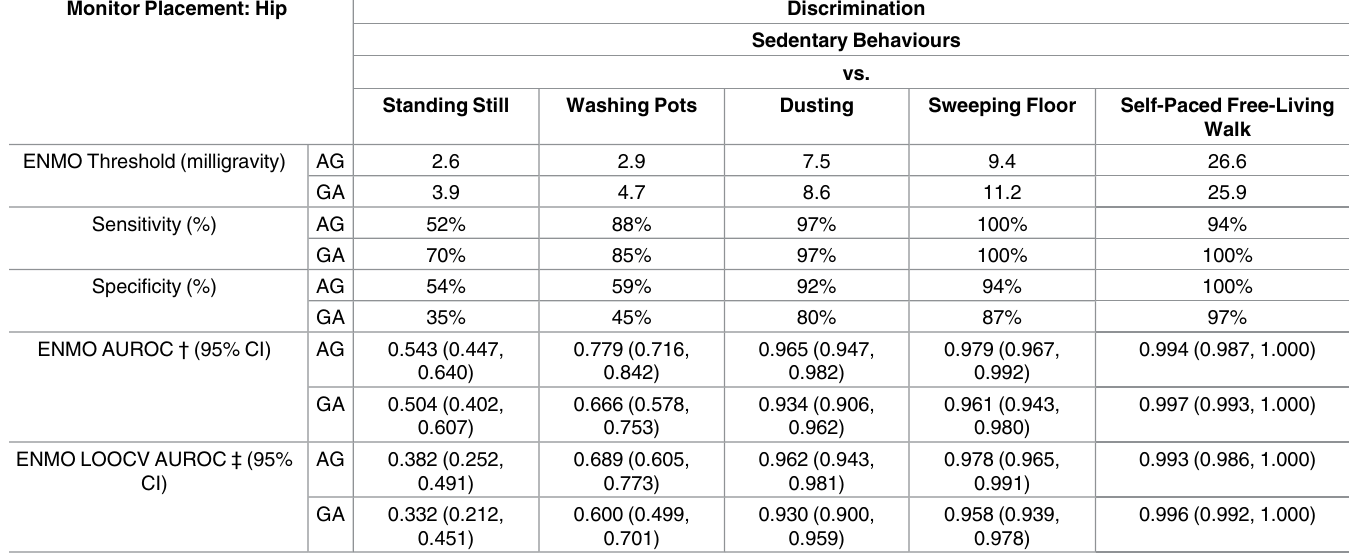
Table 4. Monitor-specific hip Euclidean Norm Minus One (ENMO (measuredin milligravity units)) thresholds to differentiate between sedentary behaviours and light-intensity physical activities. Monitor Placement: